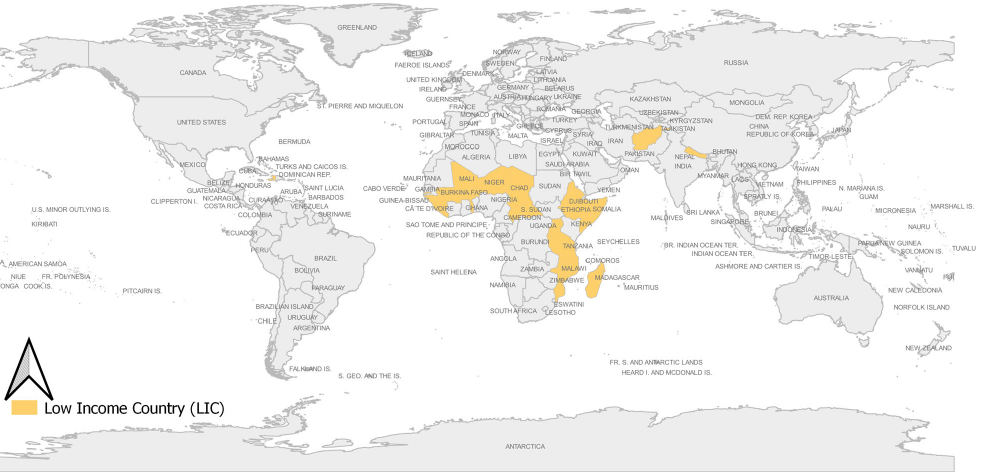
Figure 1. Study area. Asia: Afghanistan (AFG), Nepal (NPL). Africa: Central African Republic (CAF), Republic of Chad (TCD), Republic of the Congo (ZAR), Republic of Burundi (BDI), Ethiopia (ETH), State of Eritrea (ERI), Republic of Guinea (GIN), Republic of Liberia (LBR), Republic of Mad- agascar (MDG), Republic of Malawi (MWI), Republic of Mali (MLI), Republic of Mozambique (MOZ), Niger (NER), Rwanda (RWA), Republic of Seychelles (SLE), Somali Republic (SOM), South Sudan (SSD), Togolese Republic (TGO), Republic of Uganda (UGA), United Republic of Tanzania (TZA), Burkina Faso (BFA), Republic of the Gambia (GMB), Republic of Guinea-Bissau (GNB). South and Central America: Republic of Haiti (HTI). 2.2. Data Data were retrieved from international institutions that provide global data. The United Nations Statistics Division provides data from 1983 to 2018 for 122 SDG indicators (https://unstats.un.org/sdgs/indicators/database, accessed on 3 September 2021). The World Bank provided GDP per capita from 1960 to 2020 (https://data- bank.worldbank.org/source/world-development-indicators, accessed on 3 September 2021). Global population data were downloaded from the United Nations Population Di- vision (https://population.un.org/wpp/Download/Standard/Population/, accessed on 3 September 2021). The primary water-related SDG is Goal 6 (Clean Water and Sanitation). However, Goal 1 (No Poverty) [15], Goal 2 (Zero Hunger) [16], Goal 3 (Good Health and Well-being) [17], Goal 4 (Quality Education) [18], Goal 7 (Affordable and Clean Energy) [19], Goal 9 (Industry, Innovation and Infrastructure) [20], Goal 11 (Sustainable Cities and Communi- ties) [21], Goal 12 (Responsible Consumption and Production) [22], Goal 13 (Climate Ac- tions) [23], Goal 14 (Life Below Water) [24], and Goal 15 (Life on Land) utilize, or are di- rectly or indirectly influenced by water management, quantity, and quality. From 122 SDG indicators in the UN SDG database, 33 direct or indirect indicators was selected (Ta- ble 1) that covered seven water-related categories: A. extreme water events, B. water avail- ability, C. water quality and waterborne disease, D. water related to energy, E. water re- lated to industry and technology, F. water governance and management, and G. water related to ecosystems.